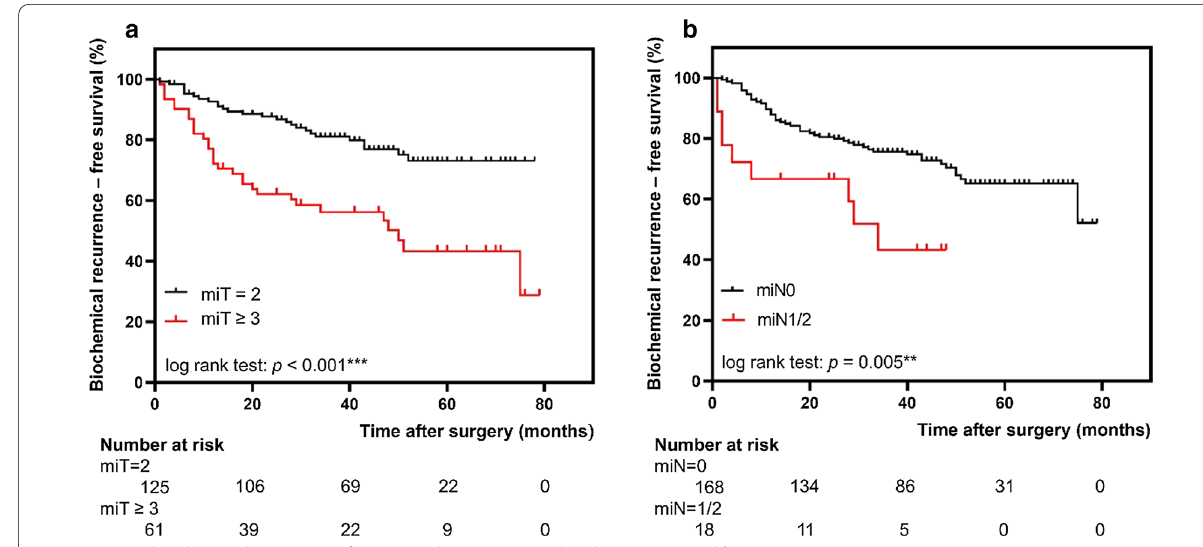
Fig. 2 Longer biochemical recurrence‑free survival was associated with a miT